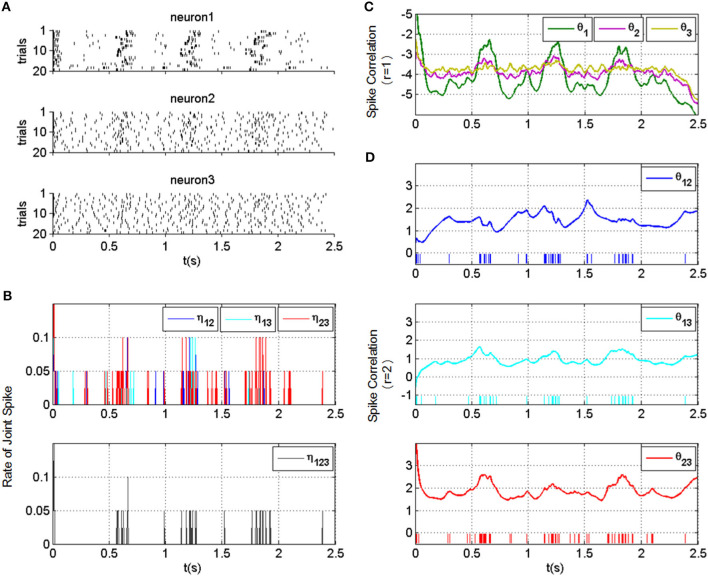
Estimation of spike correlations for acupuncture data evoked by lifting-thrusting reducing. (A) Ensemble spike activities. The number of neurons is N = 3 and the number of trials is n = 20. (B) Rates of joint spike: η12, η13, η23, and η123. (C) First-order spike correlations: θ1, θ2, and θ3 (green, pink, and yellow solid lines). (D) Second-order spike correlations: θ12, θ13, and θ23 (blue, cyan, and red solid lines). Raster with different colors at the bottom show the timing of corresponding order synchronous spikes.